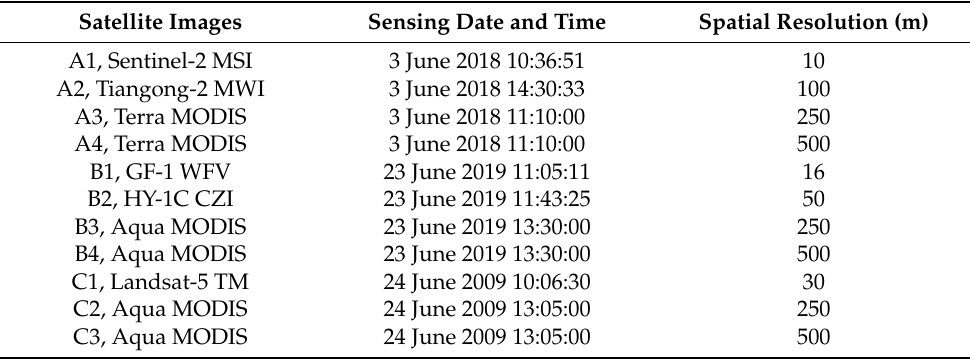
Table 1. Three groups (A, B and C) of semi-synchronous satellite images. Satellite